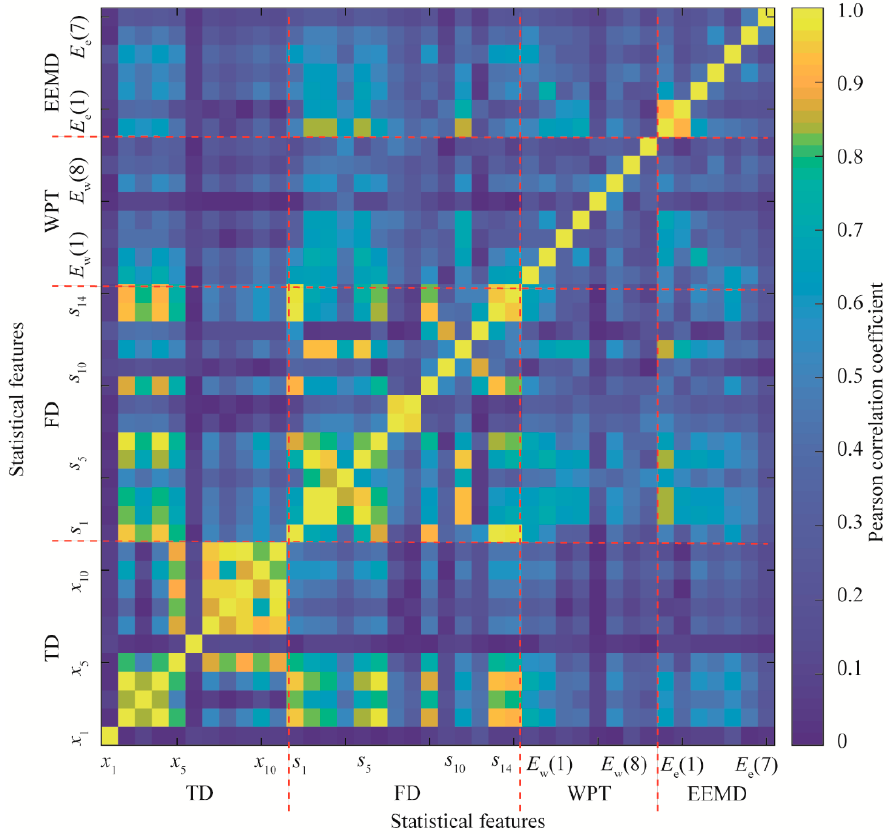
Figure 8. Correlations between statistical features. In terms of the features in the FD, the PCC between s 3 and s 2 is 0.993. The PCCs between s 5 and s 3 , s 2 equal 0.952 and 0.977, respectively. The PCC between s 8 and s 7 is 0.954. The PCC between s 9 and s 1 equals 0.920. The PCCs between s 11 and s 5 , s 3 , s 2 are 0.940, 0.926, and 0.924, respectively. The PCCs between s 13 and s 9 , s 1 equal 0.933 and 0.986, respectively. The PCCs between s 14 and s 13 , s 1 are 0.951 and 0.970,